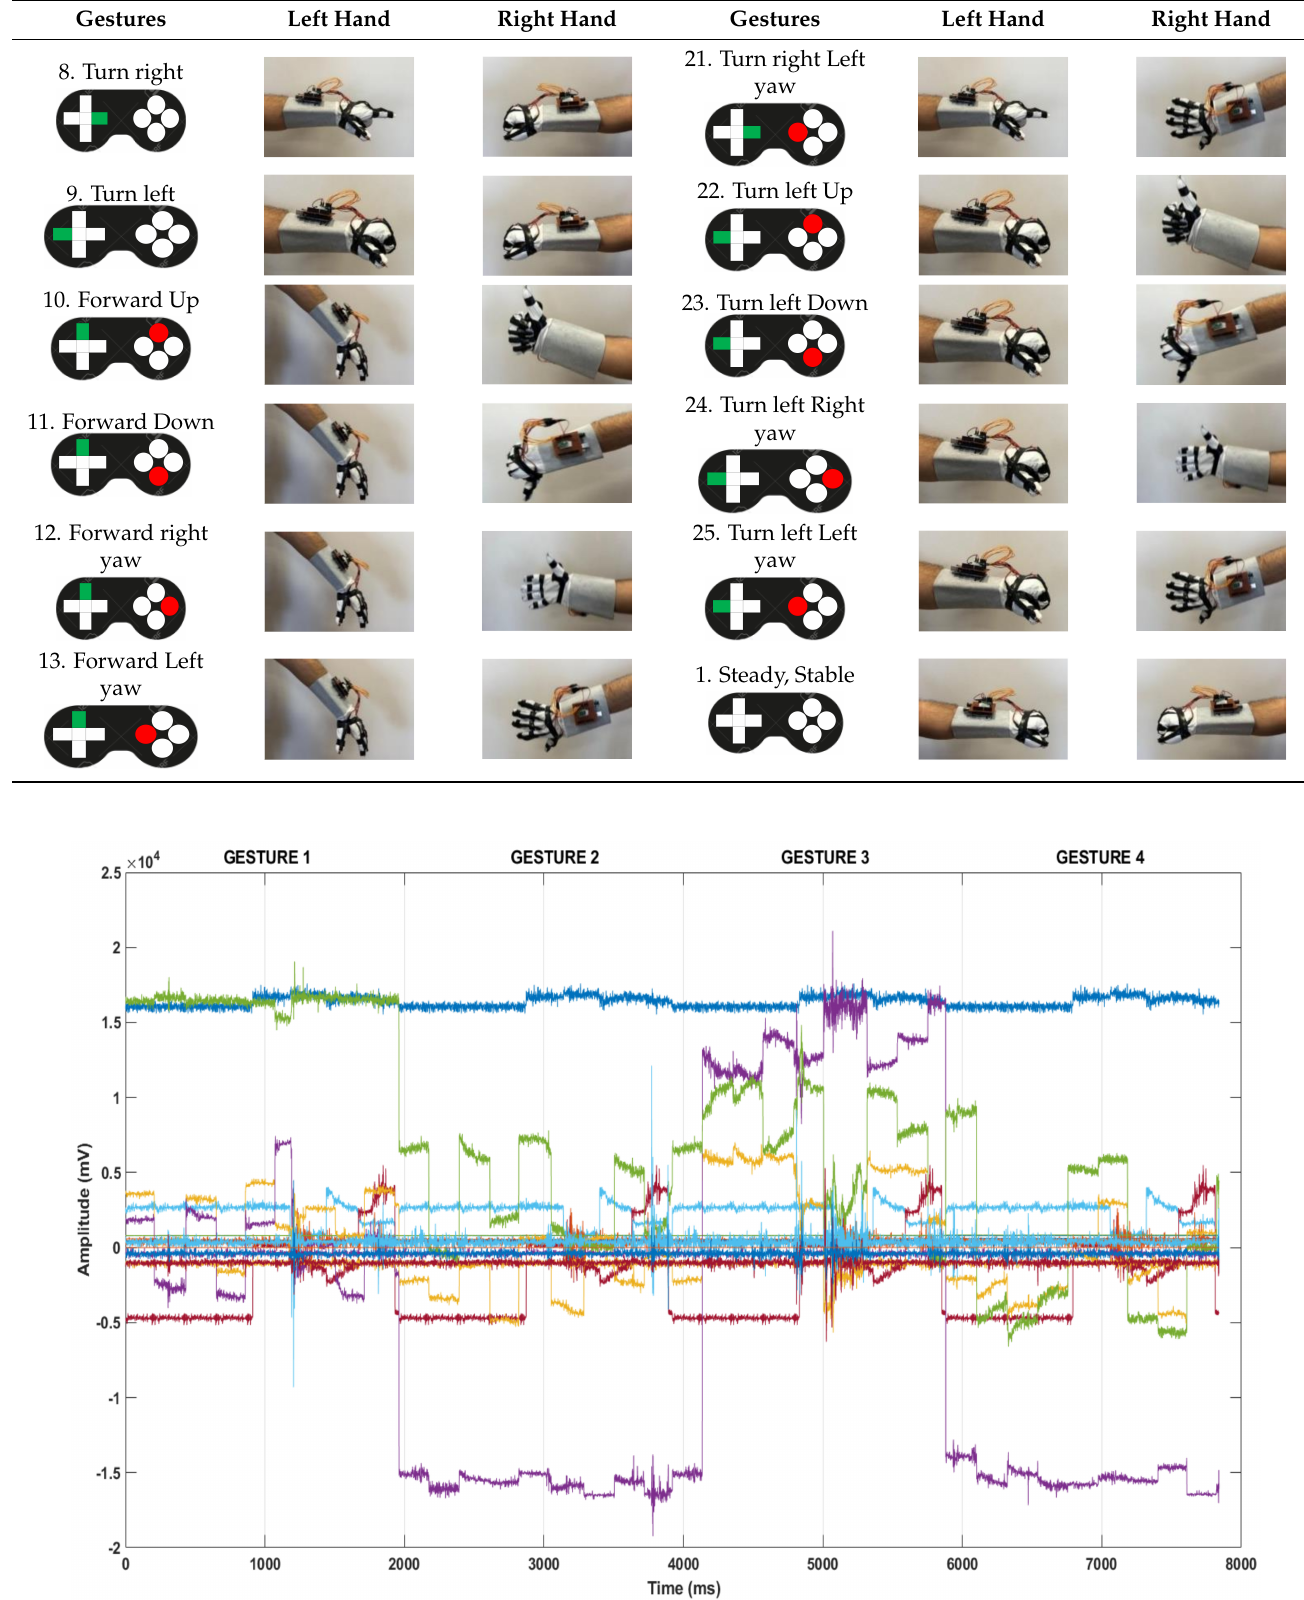
Figure 5. An example of a signal graph that occurs when 4 consecutive hand movement scenarios occur for approximately 2000